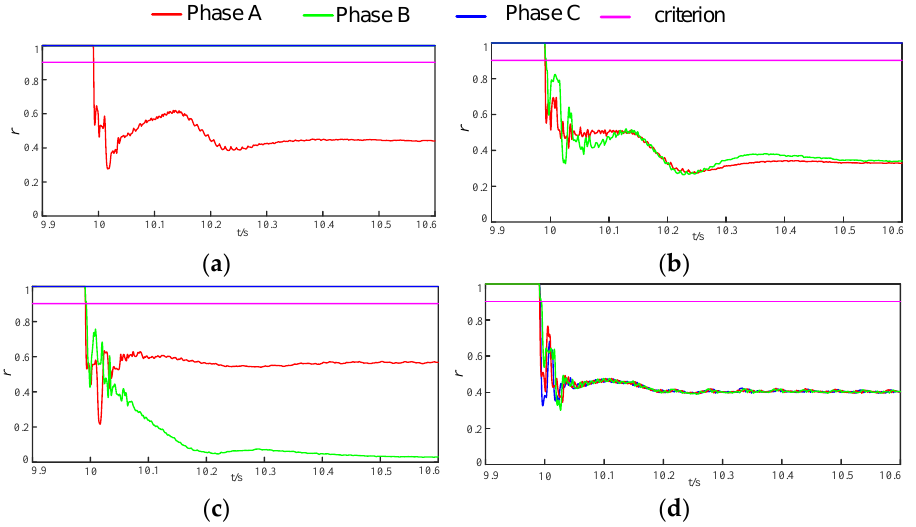
Figure 5. Performance of the proposed protection scheme under different types of faults: ( a ) single- phase grounding (phase A); ( b ) phase-to-phase grounding (phase A and B); ( c ) phase-to-phase short circuit (phase A and B); ( d ) three-phase short-circuit.